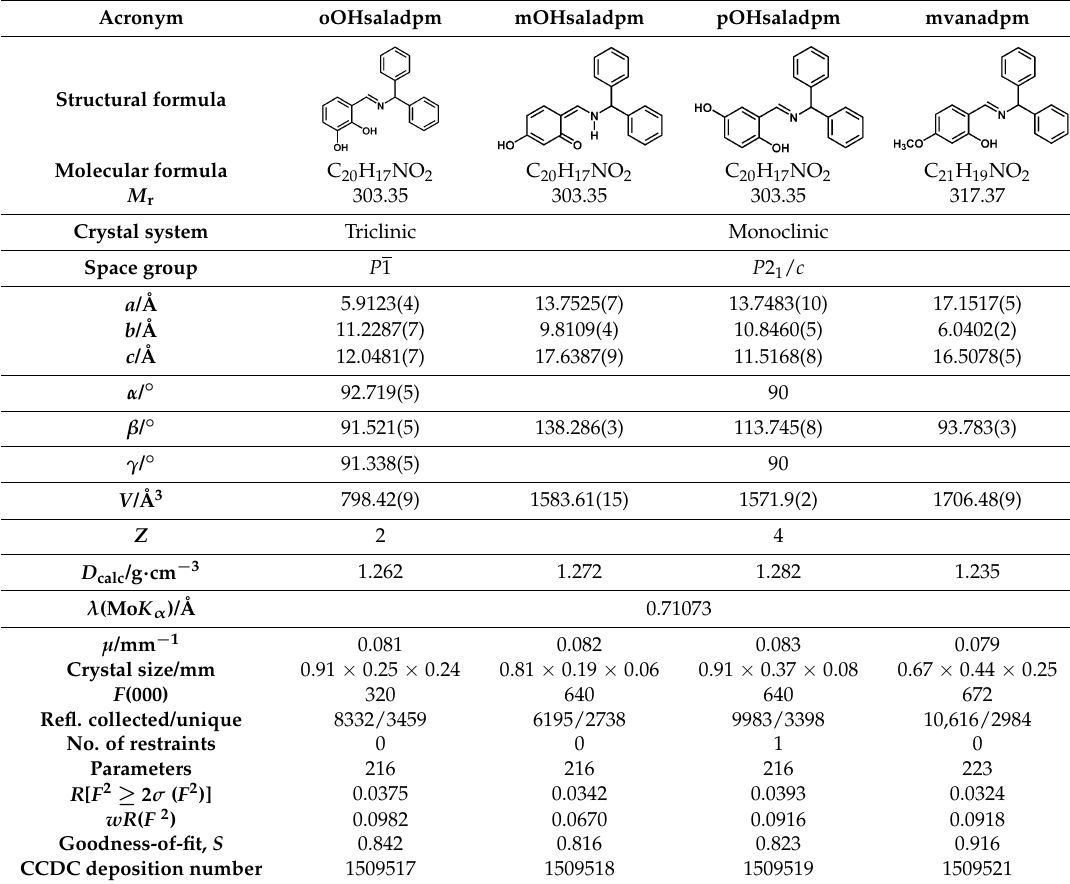
Table B1. General and crystallographic data for compounds reported in this work.